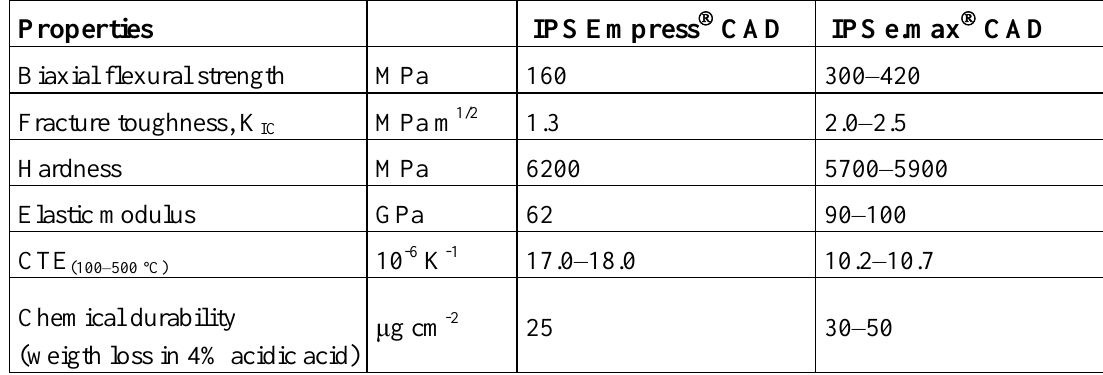
Table 1. Properties of a leucite-type glass-ceramic IPS Empress  CAD and a